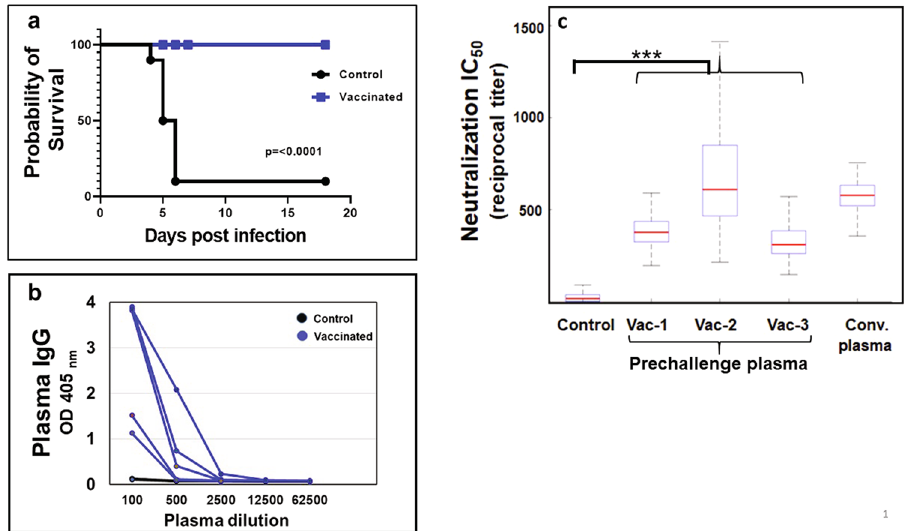
Fig. 1 Adjuvanted Spike vaccine protected against SARS-CoV-2 lethal challenge and elicited neutralizing antibody response. K18-hACE2 mice ( n = 10 per group) were immunized on days 0, 14, and 28 with adjuvanted full-length spike protein using a combination of subcutaneous (SC, days 0 and 28) and intranasal (IN, day 14) routes. Mice were challenged with SARS-CoV-2 two weeks after the fi nal immunization. a Survival analysis: Nine out of ten control mice succumbed to infection by day-6 postchallenge. All the vaccinated mice survived until the termination of the experiment (day-18). b Anti-S1 IgG: Prechallenge plasma was collected a week after fi nal immunization and anti-S1 IgG levels were measured by ELISA. c Pseudovirus entry neutralization. Prechallenge plasma obtained a week post-third immunization was evaluated to assess the ability to inhibit pseudovirus entry in Vero E6 cells. Plasma from immunized mice (Vac-1 to Vac-3) showed neutralization capability equivalent to human convalescent plasma (conv. plasma). Boxes denote mean with standard deviation. Asterisk indicates that the results are statistically signi fi cant as follows: *** p <